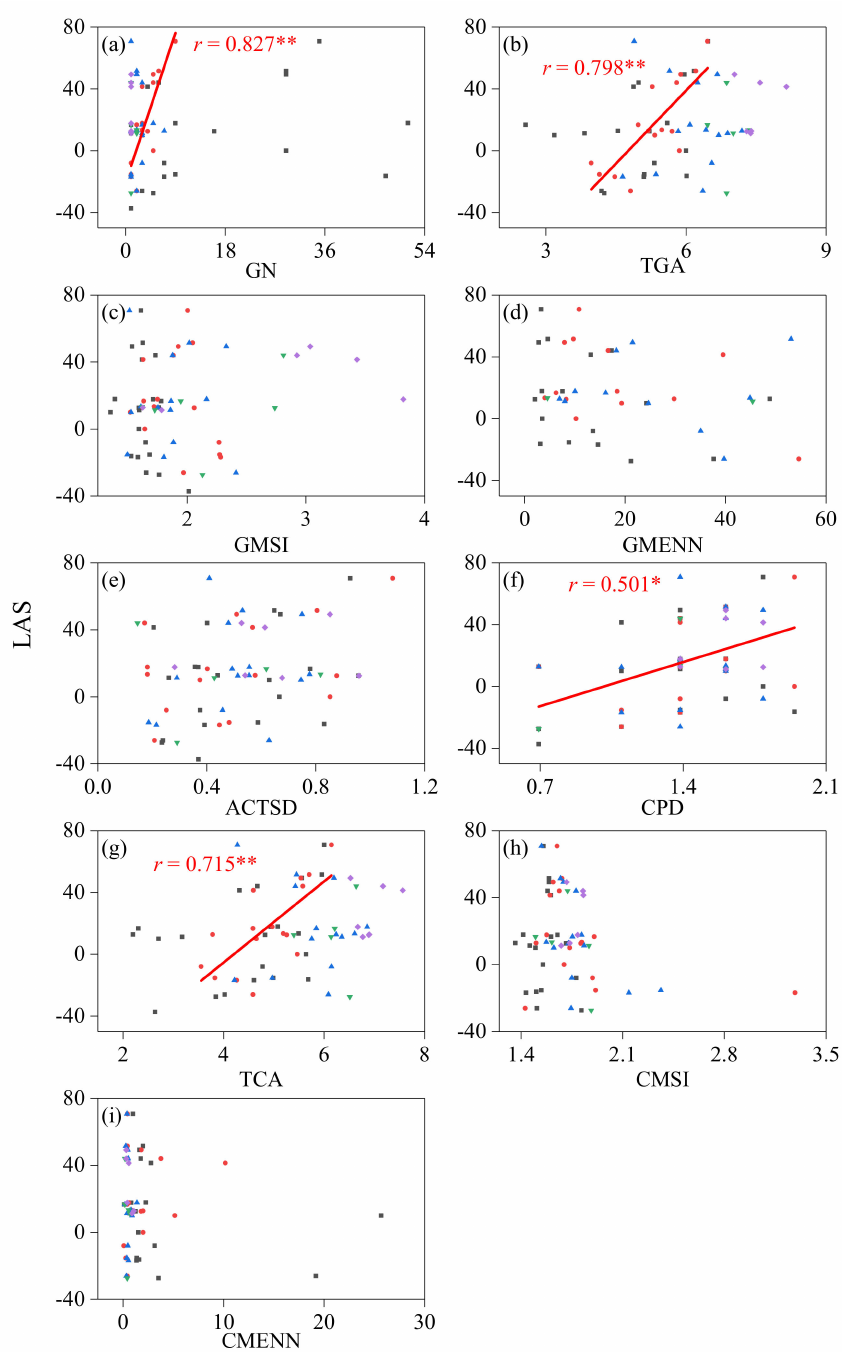
Figure 6. Relationship between LAS with ( a ) GN, ( b ) TGA, ( c ) GMSI, ( d ) GMENN, ( e ) ACTSD, ( f ) CPD, ( g ) TCA, ( h ) CMSI, and ( i ) CMENN, in different gap groups. ACTSD–autumn color-leaved tree species diversity; CMENN–mean Euclidean nearest-neighbor distance of color-leaved patches; CMSI–mean shape index of color-leaved patch; CPD–color-leaved patch diversity; GMENN: mean Euclidean nearest-neighbor distance of gaps; GMSI–mean shape index of gaps; GN–number of gaps; LAS–landscape aesthetic service; TCA–total color-leaved patch area; TGA–total gap area. Red solid lines indicate that there is a significant relationship between landscape aesthetic service with gap characteristics, ACTSD, and color-leaved patch structure attributes in the medium gap group; if there is no significant relationship, it is not marked in the figure; * and ** indicate p < 0.05 and p < 0.01,